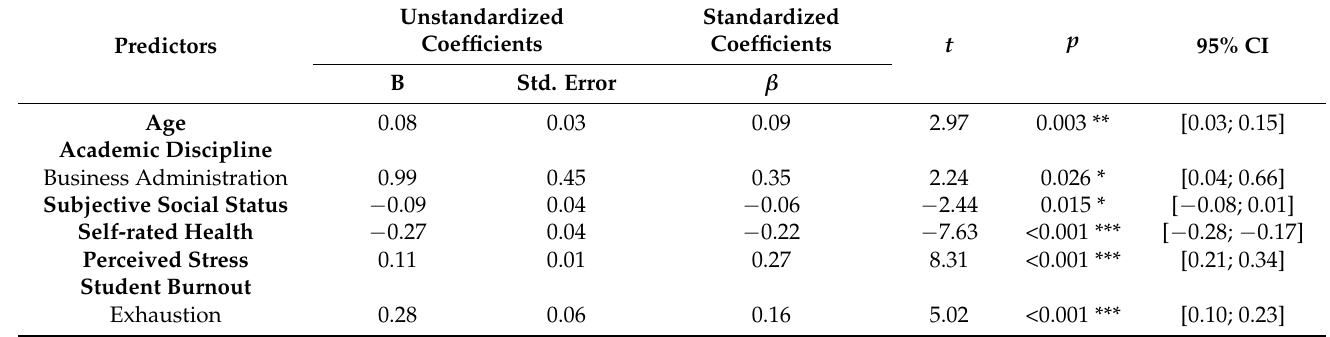
Table 4. Significant results of multiple regression analysis with sleep quality as the dependent